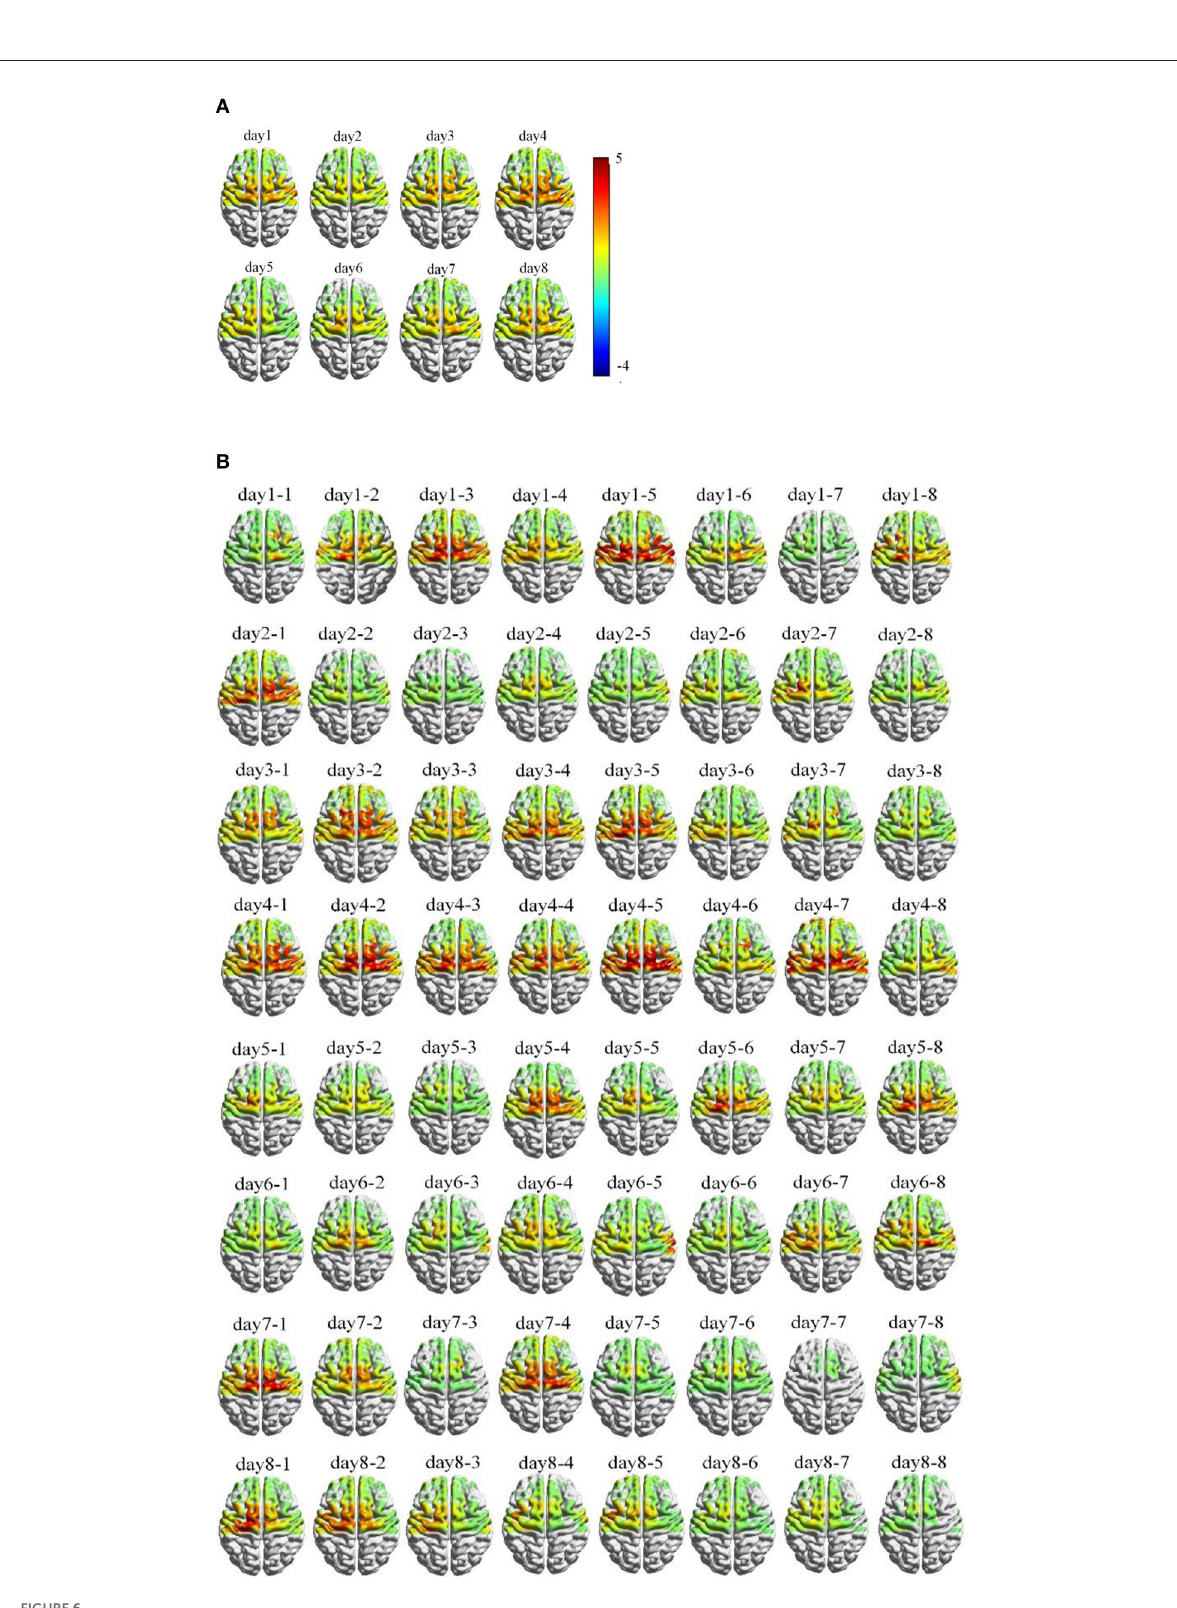
FIGURE6 Example of cortical hemodynamic response of one typical participant during training process, mapped by 1 [HbO] activation and arranged in temporal sequence (A) per day; (B) per